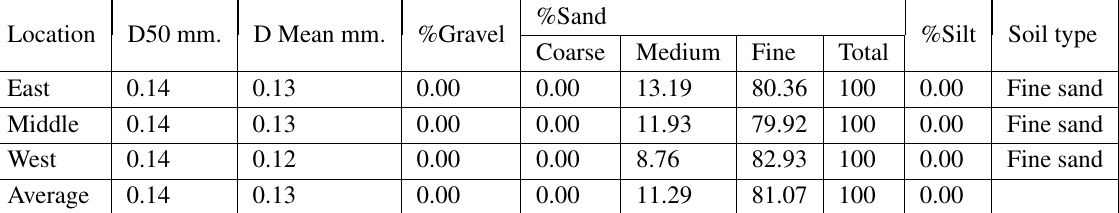
Table 1. The soilcharacterized to the bed at 6 th October